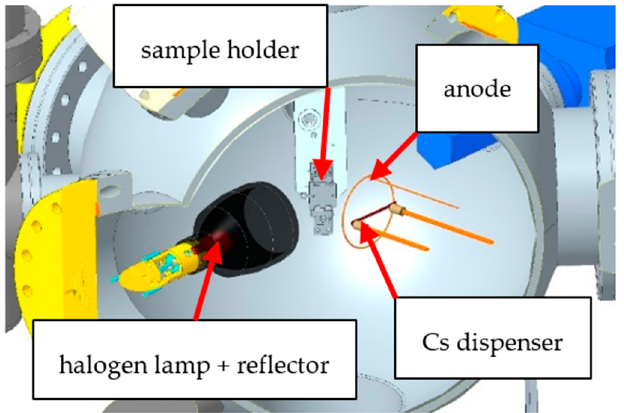
Figure 1. Scheme of the UHV chamber, showing the sample holder, the halogen lamp with reflector, the copper anode and the cesium (Cs) dispenser.